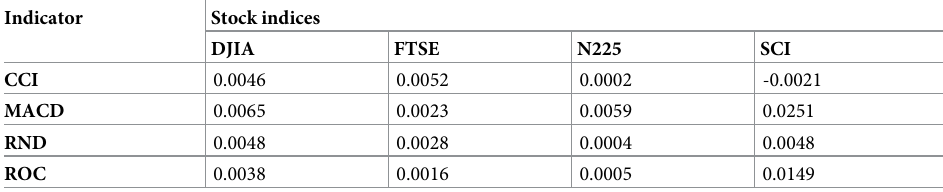
Table 3. The � r � of the technical trading rules for the stock